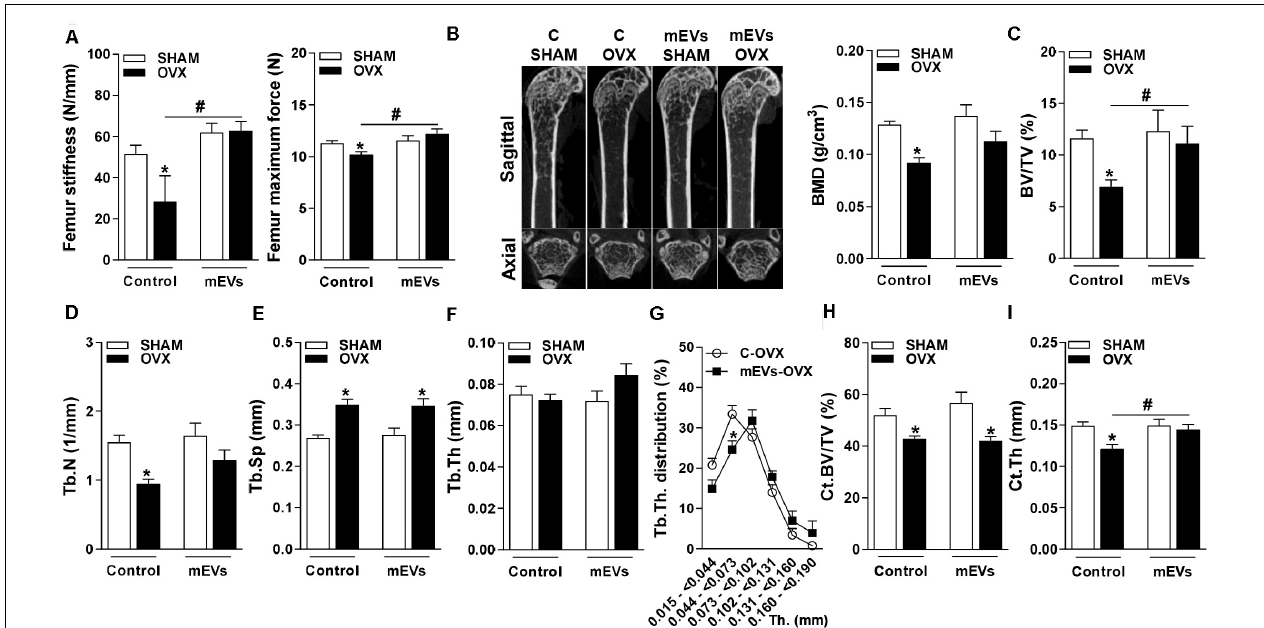
FIGURE 3 | Mechanical analysis in the femur and micro-computed tomography analysis of trabecular and cortical bone in the distal femur of mice treated with milk extracellular vesicles (mEVs). (A) Stiffness and the maximum bone load of the femur. (B) Representative pictures of distal femur microarchitecture and bone mineral density (BMD), (C) trabecular bone volume fraction (BV/TV), (D) trabecular number (Tb.N), (E) trabecular separation (Tb.Sp), (F) trabecular thickness (Tb.Th), (G) trabecular thickness distribution (Tb.Th distribution), (H) cortical bone volume per tissue volume (Ct.BV/TV), and (I) cortical thickness (Ct.Th). Analyses were performed in mice (i) pseudo-operated (SHAM) or (ii) ovariectomized (OVX), (iii) non-treated (control), or (iv) treated with mEVs. Values are means ± SEM of 6–8 animals per group. * vs. respective SHAM group and # vs. non-treated group, P < 0.05.